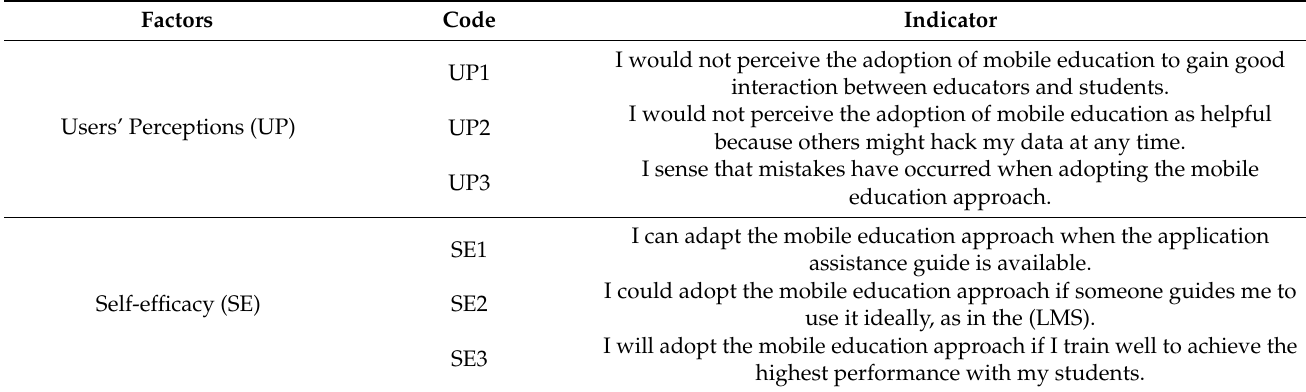
Table 1. Questionnaire factors